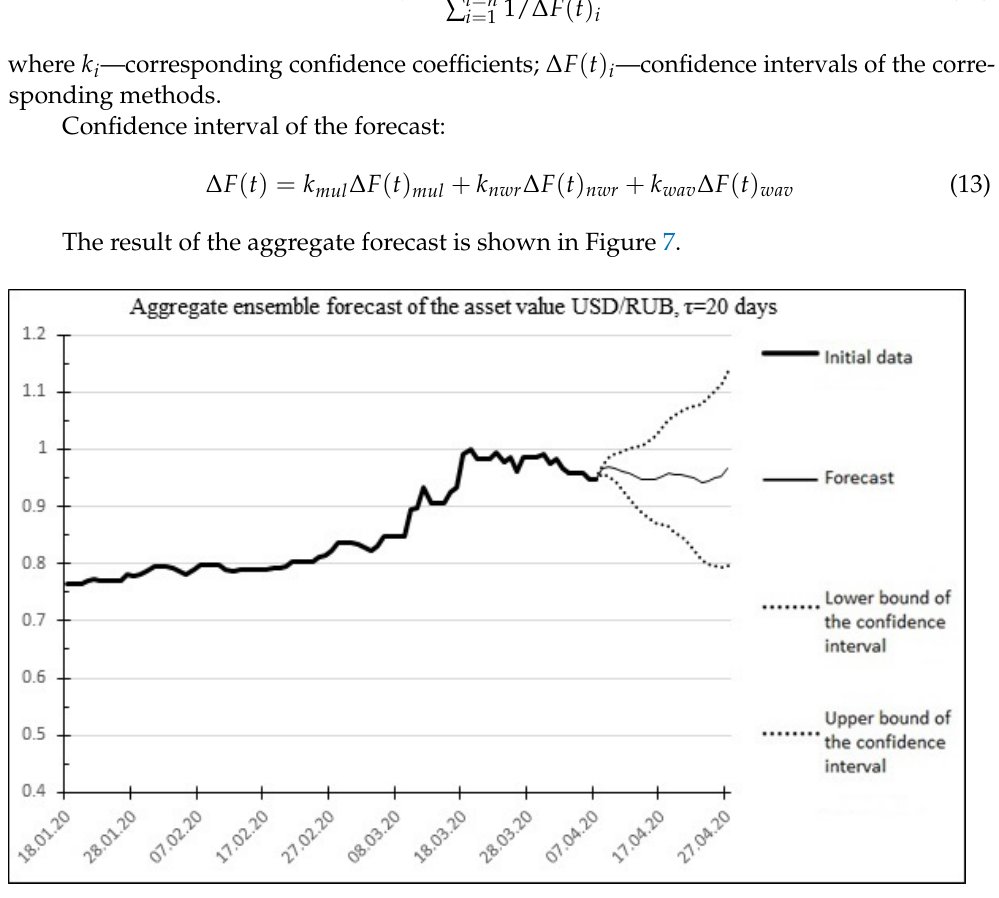
Figure 7. The result of the aggregate forecast for 20 days ahead for the USD/RUB